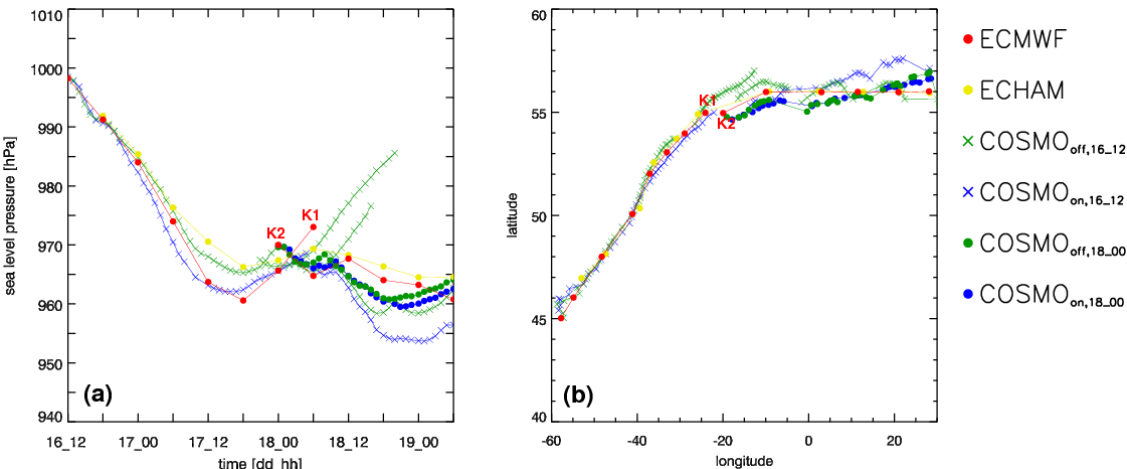
Fig. 11. (a) Temporal development of minimum sea level pressure (in hPa, from 12:00UTC 16 January to 06:00UTC 19 January), and (b) the track of winterstorm “Kyrill” to the east of 60 ◦ W for different model simulations and ECMWF analyses. Label K1 denotes the end of the original cyclone, label K2 denotes the beginning of the second depression. shown by Fink et al. (2009), damage occurred in an excep- tionally large area (compared to other damaging European winterstorms). In the following, we focus on the representa- tion of the development of “Kyrill” over the North Atlantic in the model simulations, in particular on the track and the de- velopment of minimum sea level pressure (SLP) for K1 and K2. Because of the fairly large domain required to capture